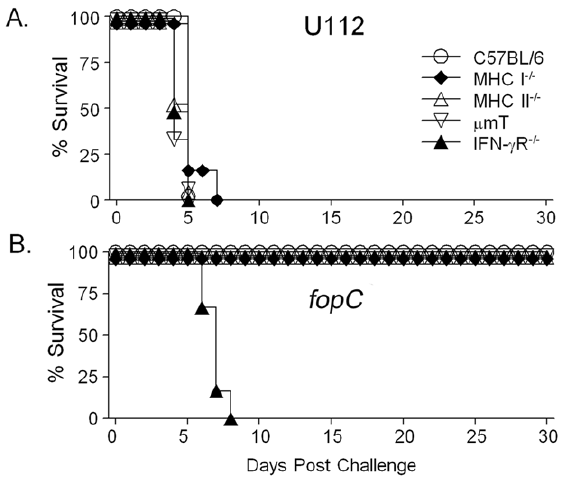
Figure 3. Susceptibility of knockout mice to wildtype and fopC mutant challenge. Different KO strains of mice (6/group) were challenged i.n. with 10 3 CFU wildtype U112 (A) or fopC mutant (B). Difference in survival between fopC mutant challenged C57BL/6 and IFN- c R 2 / 2 mice was significant at a p , 0.001. All animals were monitored daily for survival over 30 days. (Representative of two experiments.)